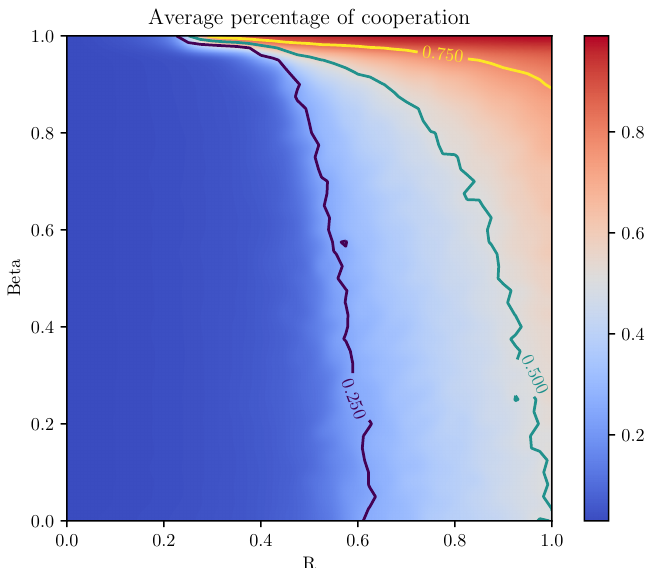
Figure 4. The figure depicts the average percentage of contributions as a function of the rate of return R = 0.25 and/or too low values and the level of noise in the matching mechanism β . For values of R ≤ 1 s of β , we observe no cooperation. Otherwise, as predicted, the average level of cooperation weakly increases with increasing R and β , and we observe almost complete cooperation when approaching one. The contour lines indicate when the average contribution is above 25%, 50% and 75% of the whole population, respectively. The simulation was obtained for the following set of parameters: N = 80, s = 4, λ = 30, EN = 100, p = 0.99, T =